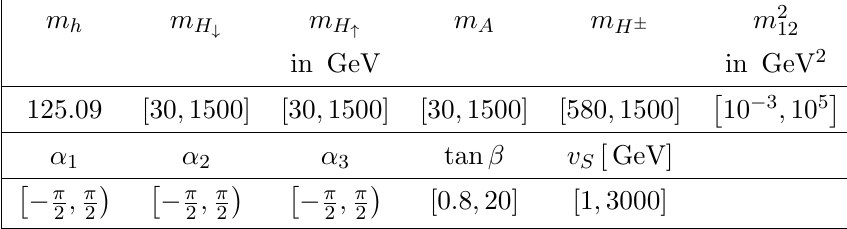
Table 3 . Parameter ranges for the N2HDM T2 input parameters used in ScannerS .